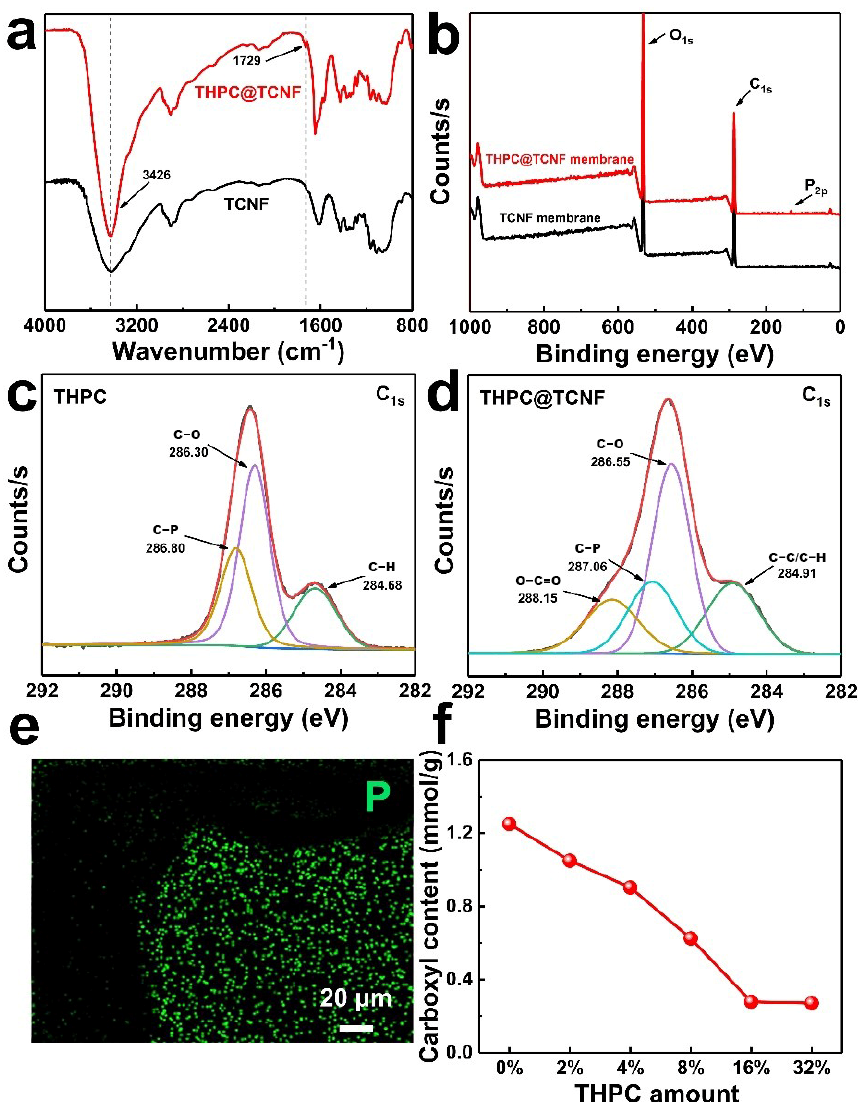
Figure 3. ( a ) FT-IR spectra and ( b ) XPS spectra of TCNF membrane and THPC@TCNF